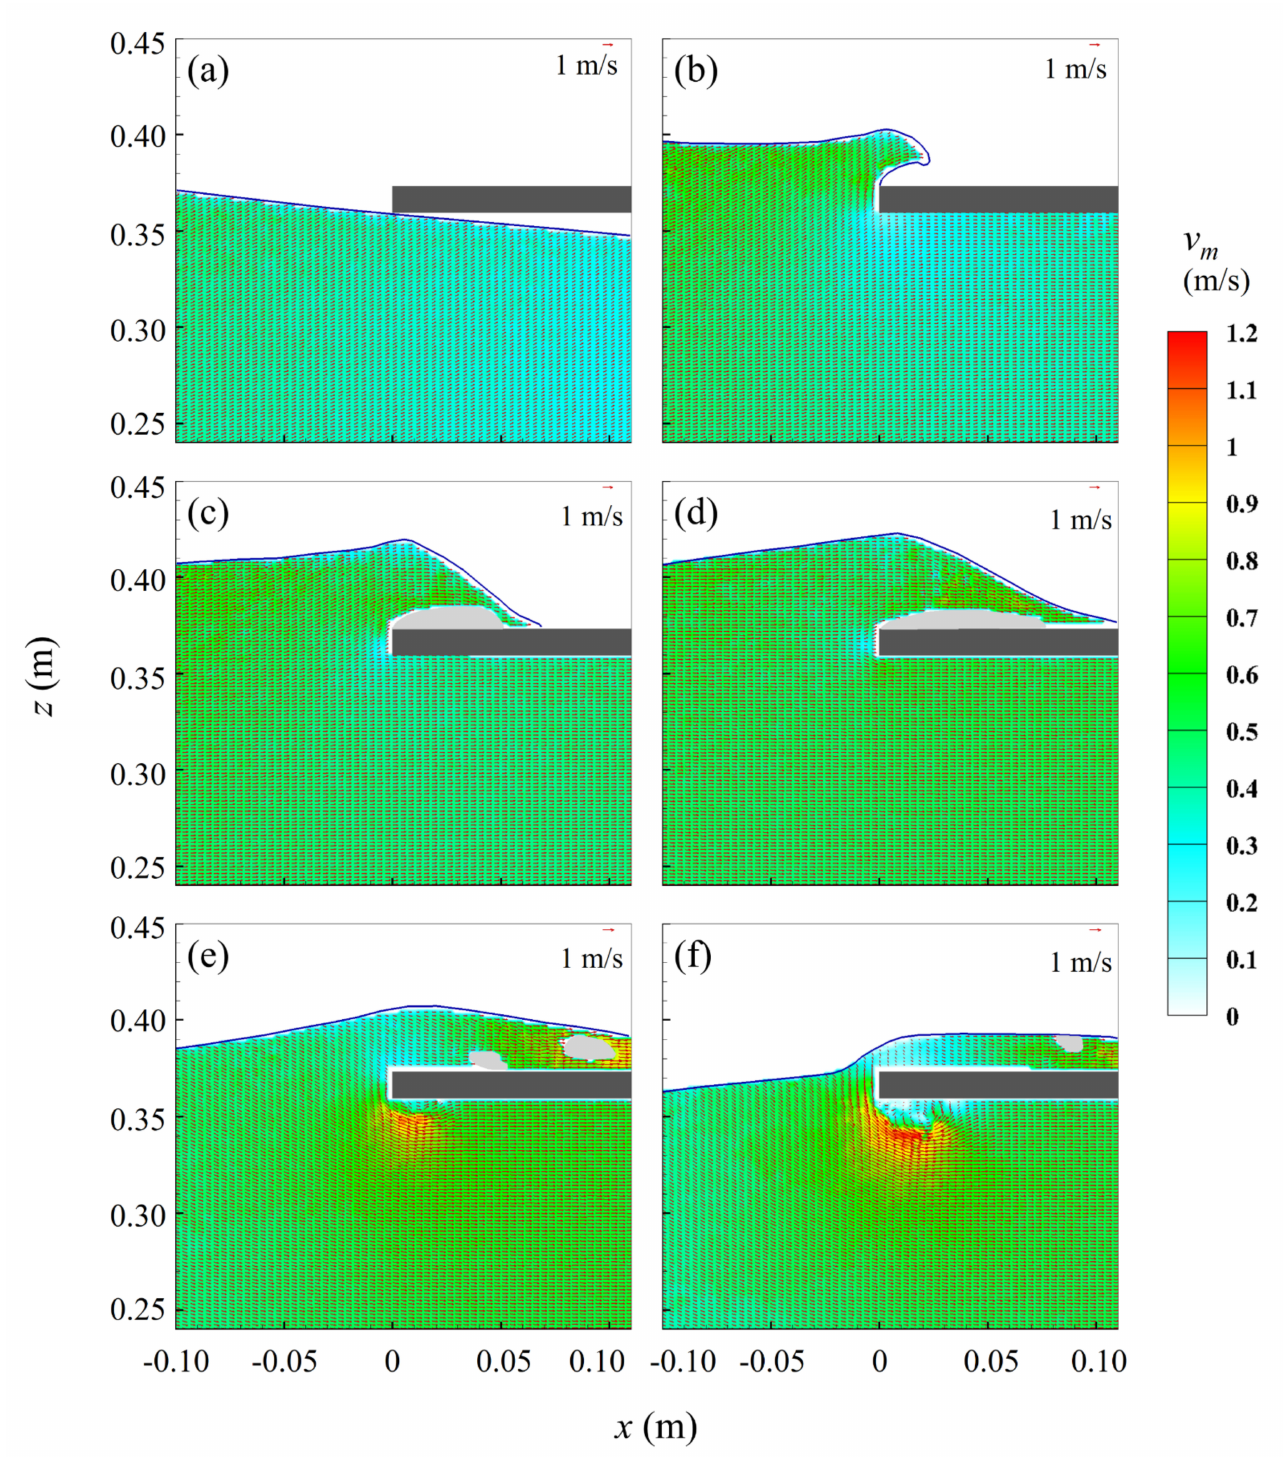
Figure 4. Detailed weather–side velocity evolution around the plate of Case 1, D / h = 6/30, H / h = 10/30. T = ( a ) 0; ( b ) 0.17; ( c ) 0.31; ( d ) 0.42; ( e ) 0.62; and ( f )